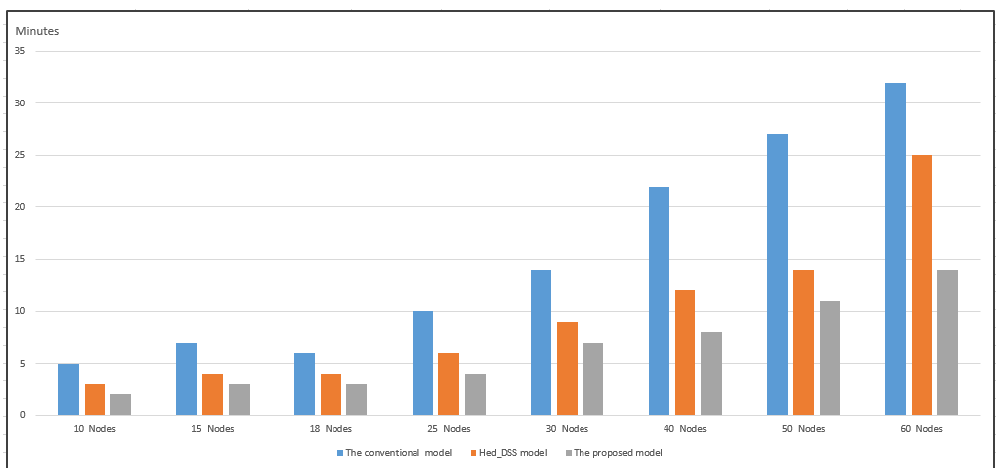
Figure 13. The Evaluation of time in 5 decision-making objects with a variety of nodes.